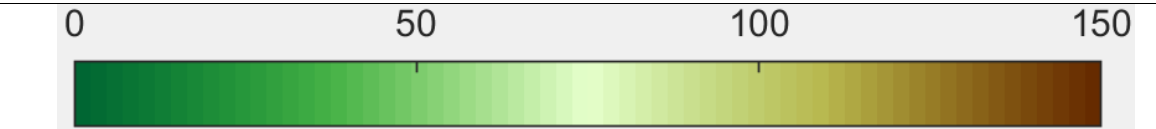
Figure 12. Ratio of monthly actual evapotranspiration and monthly dew yield ( ET / H d,i ) for 4 specific years (2025, 2050, 2075, 2100) according to the projections of RCPs 2.6 and 8.5 climate models. The study is concerned with the driest period (April to October). The white pixels, mainly located S and SW, correspond to H d,i = 0 mm·mth − 1 , thus ET / H d → ∞ . The resolution is 12.5 × 12.5 km 2 . The red points are Meteo stations as described in Table 1 and Figure 1.